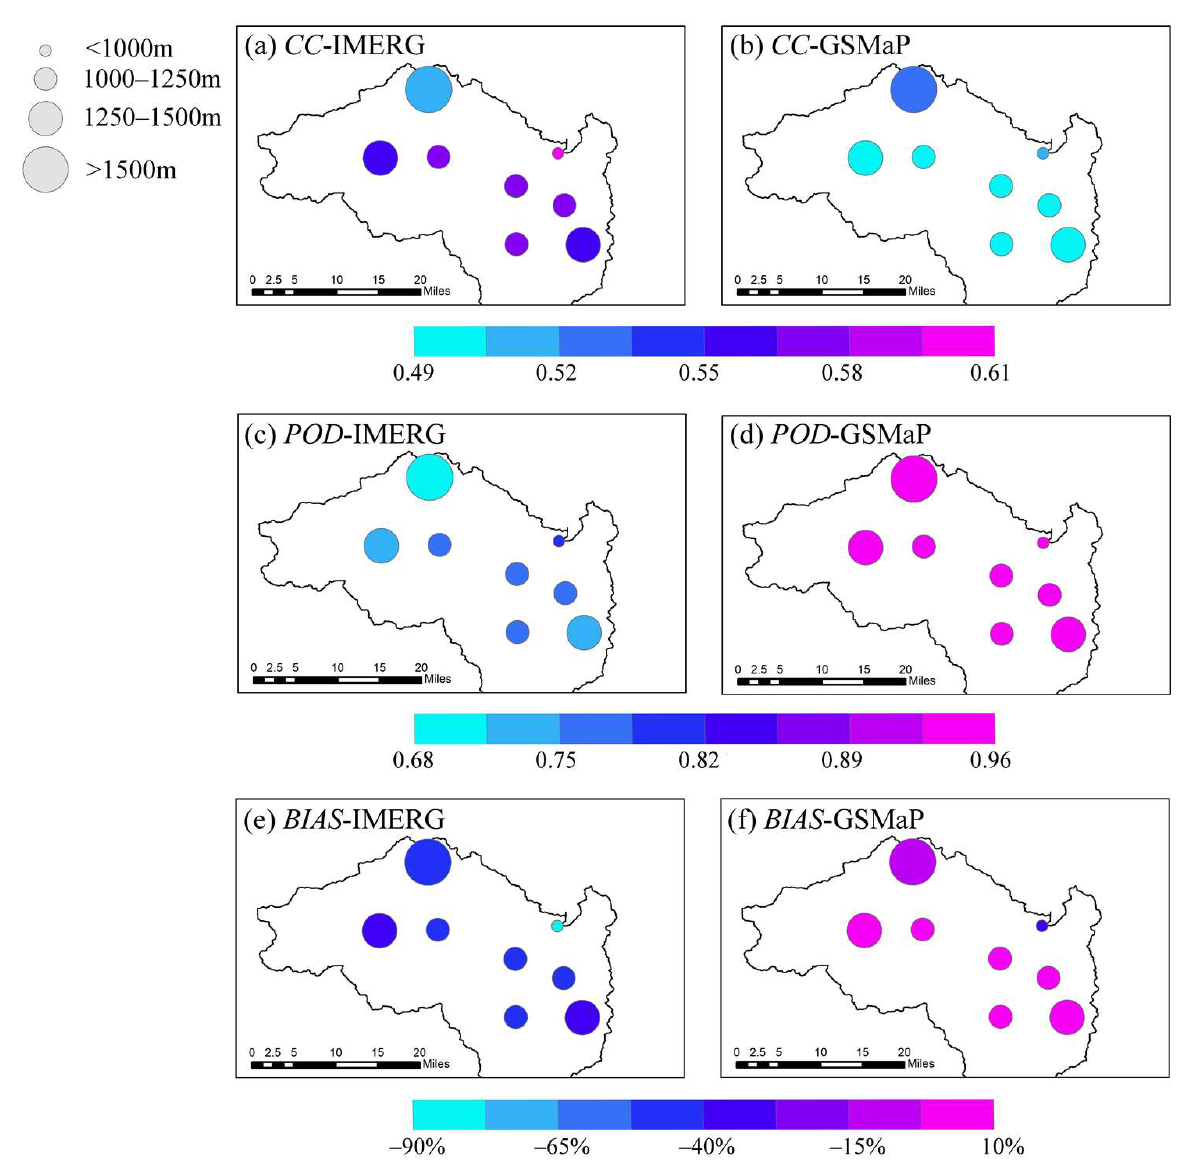
Figure 6. The correlations of the performance of IMREG and GSMaP with elevation. ( a , b ) CC ; ( c , d ) POD ; ( e , f ) BIAS .